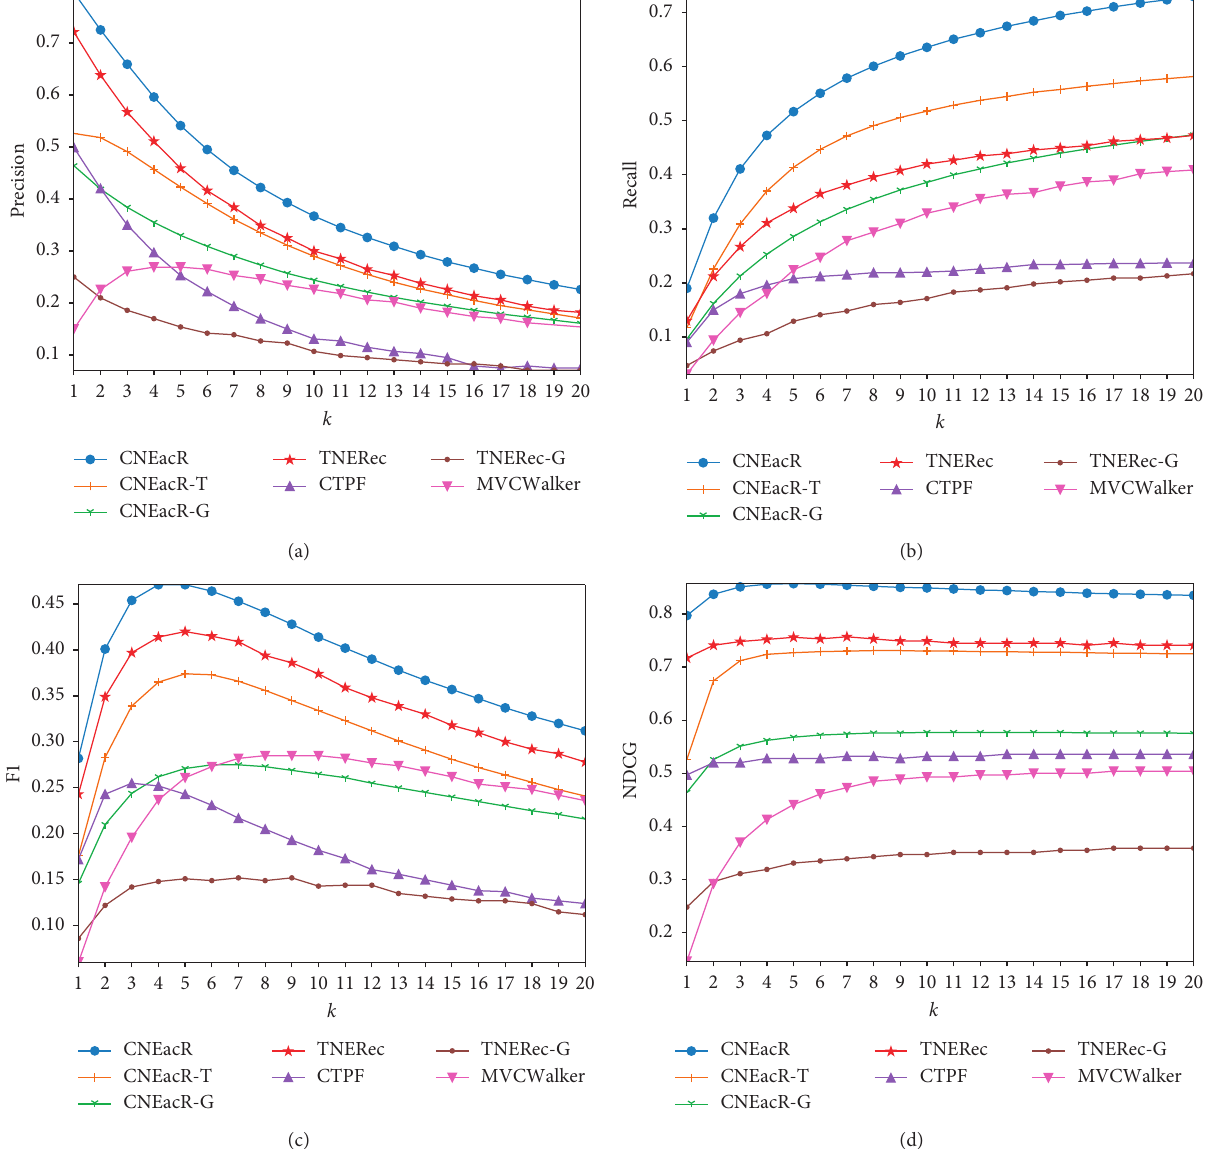
Figure 4: Performance in different k . (a) Precision in different k . (b) Recall in different k . (c) F1 in different k . (d) NDCG in different k